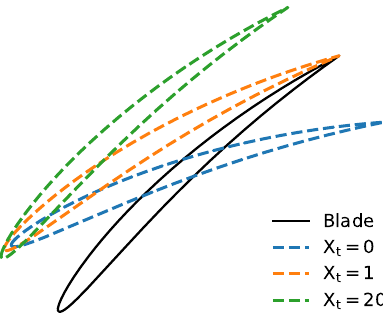
Figure 2. Schematic illustration of modeshape at different X t .